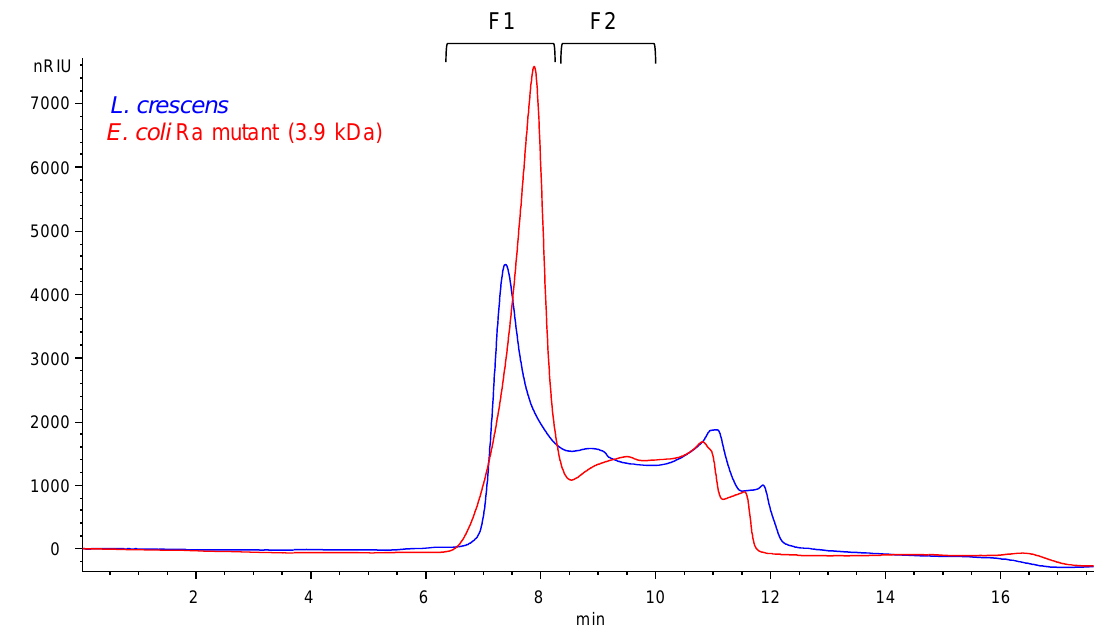
Figure 2. SEC chromatogram of the O -polysaccharide released from the Lcr. The chromatogram from Lcr O -polysaccharide was overlaid with the core region released from E. coli EH100 (Ra mutant, 3.9 kDa). Fractions 1 and 2 (F1, F2) indicate two collected fractions that were used for composition analysis.